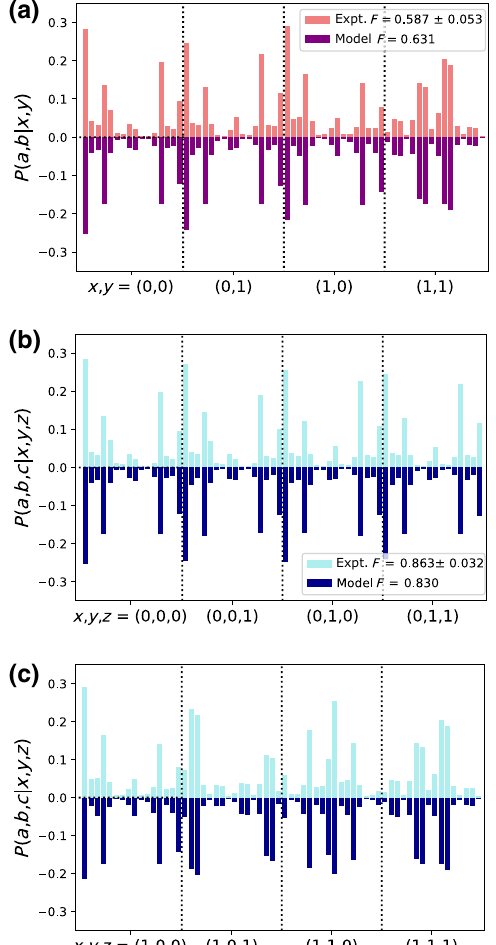
FIG. 6. Noise theoretical model. The histograms show a com- parison between the experimentally observed frequencies and the probability distributions that are expected by the noise model of the state generated by the sources involved. In particular, we consider each source to generate the state ρ λv = v | ψ (cid:3)(cid:8) ψ | + ( 1 − v) [ (λ/ 2 )( | 01 (cid:3)(cid:8) 01 | + | 10 (cid:3)(cid:8) 10 | ) + ( 1 − λ)( I / 4 ) ], which